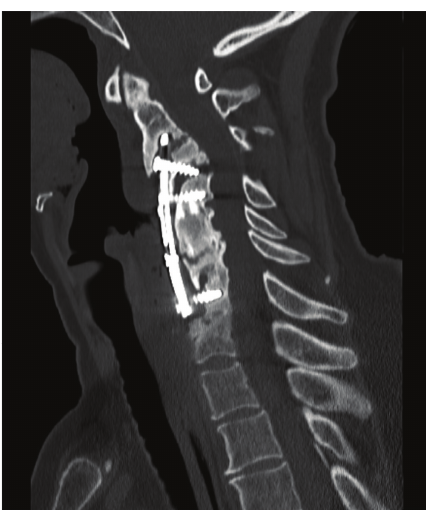
Figure 1: Plain radiograph, lateral view, of the cervical spine demonstrates air that appears to be communicating with plate. Figure 2: Sagittal CT view shows evidence of pseudarthrosis, lucency around screws at C3 and C7, and anterolisthesis of C2 in relation to C3, with the C2 vertebra overriding the superior aspect of the metallic plate.